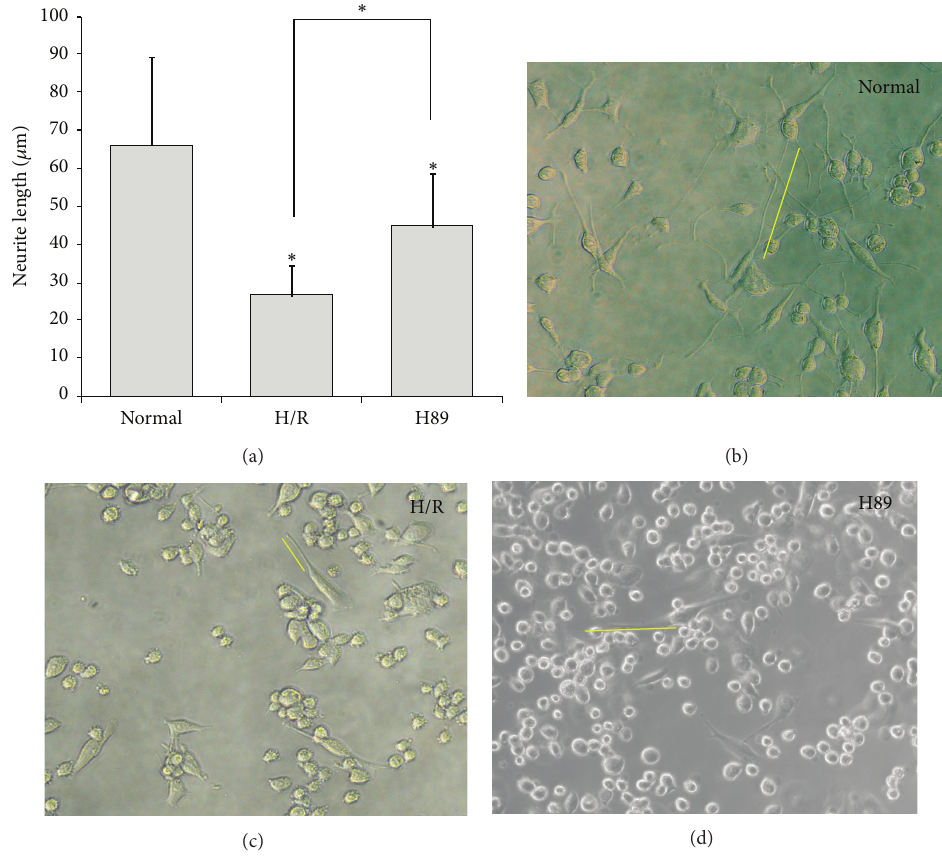
Figure 3: The measurement of neurite outgrowth in Neuro2A cells. (a) The graph of neurite outgrowth length ( 𝜇 m) in all groups. The neurite length significantly decreases in N2A cells against hypoxia reperfusion injury. Data are expressed as mean ± S.E.M. Significant intergroup differencesweredeterminedbyone-wayanalysisofvariance(ANOVA)followedbyBonferroniposthocmultiple-comparisontest.Differences were considered significant at ∗ 𝑃 < 0.05 . (b) The image using bright field microscope in the normal group shows well developed neurite of N2A cells. (c) The image using bright field microscope in hypoxia reperfusion group shows shorter neurite outgrowth of N2A cells than the normal group. (d) The image using bright field microscope in H89 group shows well developed neurite of N2A cells compared to the hypoxia reperfusion group. Each experiment included 3 repeats per condition. H89 protected N2A cells against the neurite damage under H/R injury. Normal: the normal control group, H/R: 4hr hypoxia and 18hr reperfusion injury group, and H89: 2 hr PKA inhibitor H89 treatment group before 4hr hypoxia and 18hr reperfusion